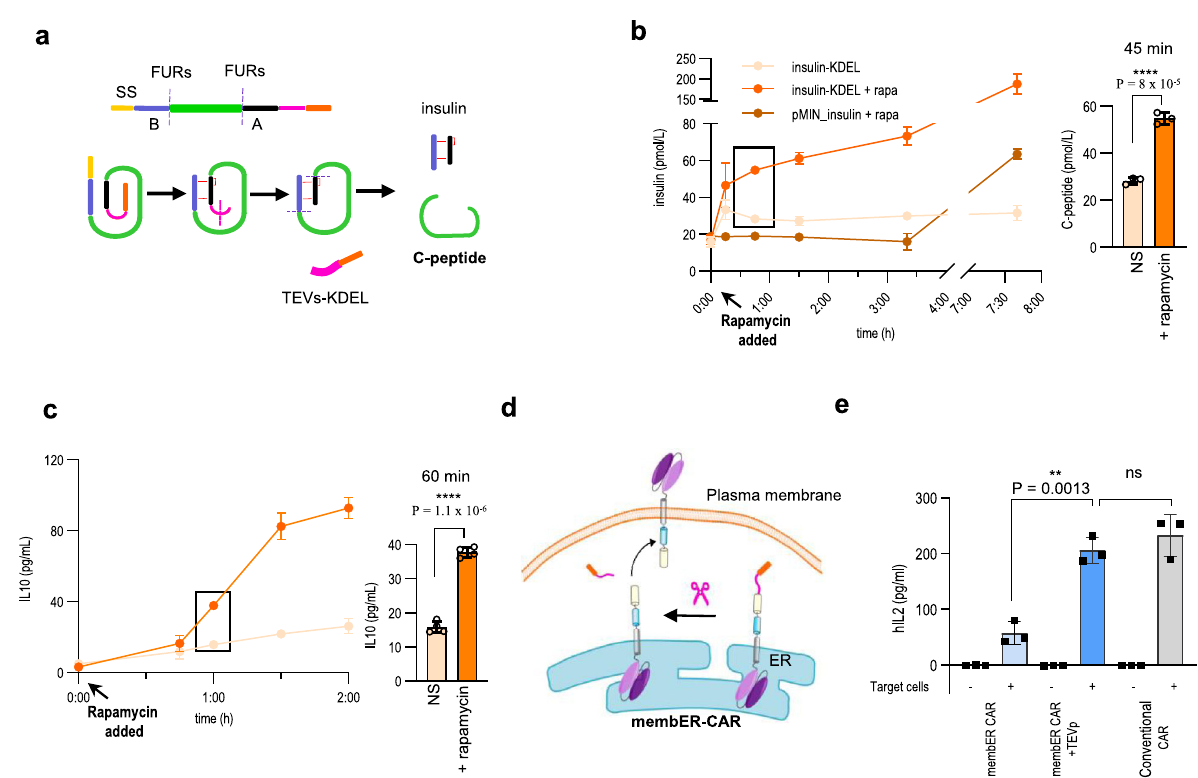
Fig. 6 Inducible secretion and translocation of therapeutic proteins based on the chemically regulated lumER and membER systems. a A modi fi ed preproinsulin sequence was designed to feature FURs (purple lines) between B (blue)/C-peptide (green) and C/A-peptide (magenta). After removal of the retention signal, the proinsulin passes GA, where it is processed to the mature insulin by FURp. Media were harvested at speci fi ed time points and C-peptide ELISA was performed to measure the amount of processed insulin. b C-peptide concentration was measured in the cell media after the addition of rapamycin, as well as from non-stimulated (NS) cells. Secretion kinetics of the lumER-insulin system was compared to the kinetics of secreted insulin in an inducible transcription-activation system. The secretion was compared with cells, which were not stimulated with rapamycin. c hIL10 concentration was measured in the cell media after the addition of rapamycin, as well as from NS cells. Values are the mean of three cell cultures ± s.d. and are representative of two independent experiments. An unpaired two-tailed t test (after equal variance was assessed with the F test assuming normal data distribution) was used for the statistical comparison of the data. d Scheme for membER CAR T translocation from ER to plasma membrane after proteolytic cleavage. e Secretion of hIL-2 as a result of activation of Jurkat cells expressing membER CAR T by addition of Raji cells. Values are the mean of three ( e ) and four ( b , c ) cell cultures ± s.d. and are representative of two ( b ) and three ( c , e ) independent experiments. An unpaired two-tailed t test with Welch ’ s correction was used for statistical comparison of the data. Source data are provided as a Source Data fi